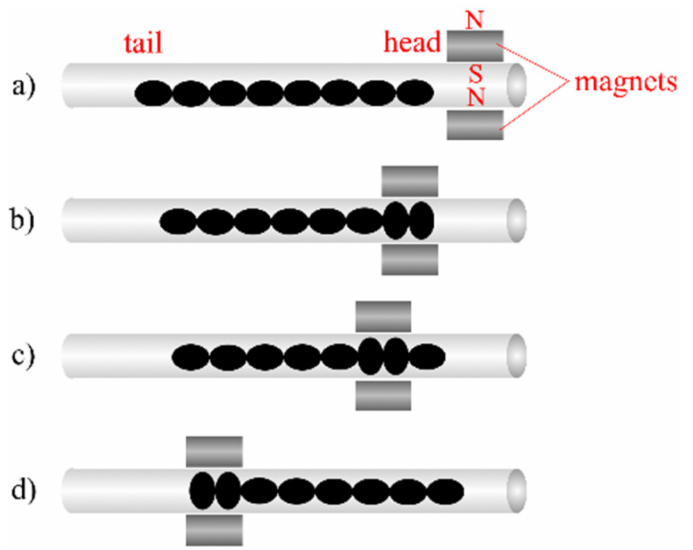
Figure 2. Mechanism of peristaltic locomotion. ( a ) The robot in resting state before actuation. ( b ) The first two spheroid units of the robot are deformed. ( c ) Ellipsoid units of robot are deformed sequentially as magnets move from head to tail. ( d ) Robot advances forward due to combined effect of contraction and release of individual